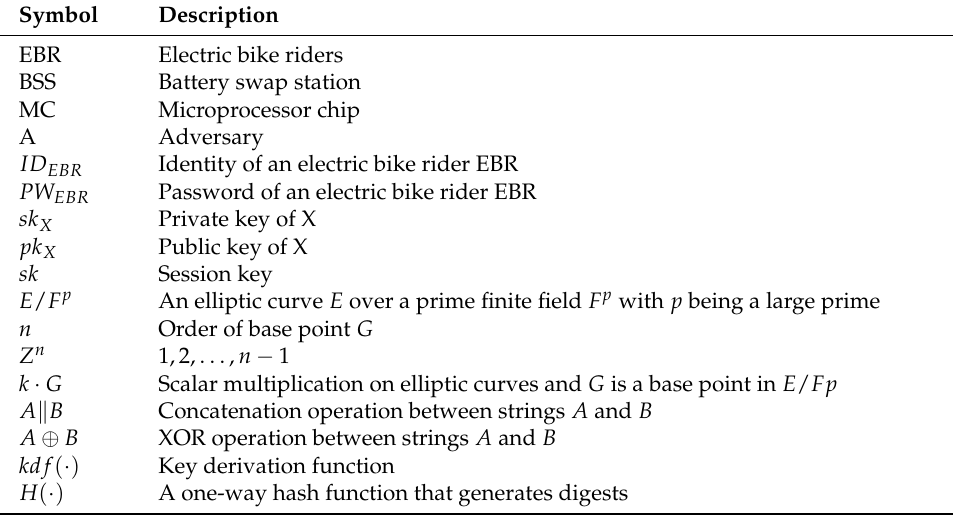
Table 1. List of used